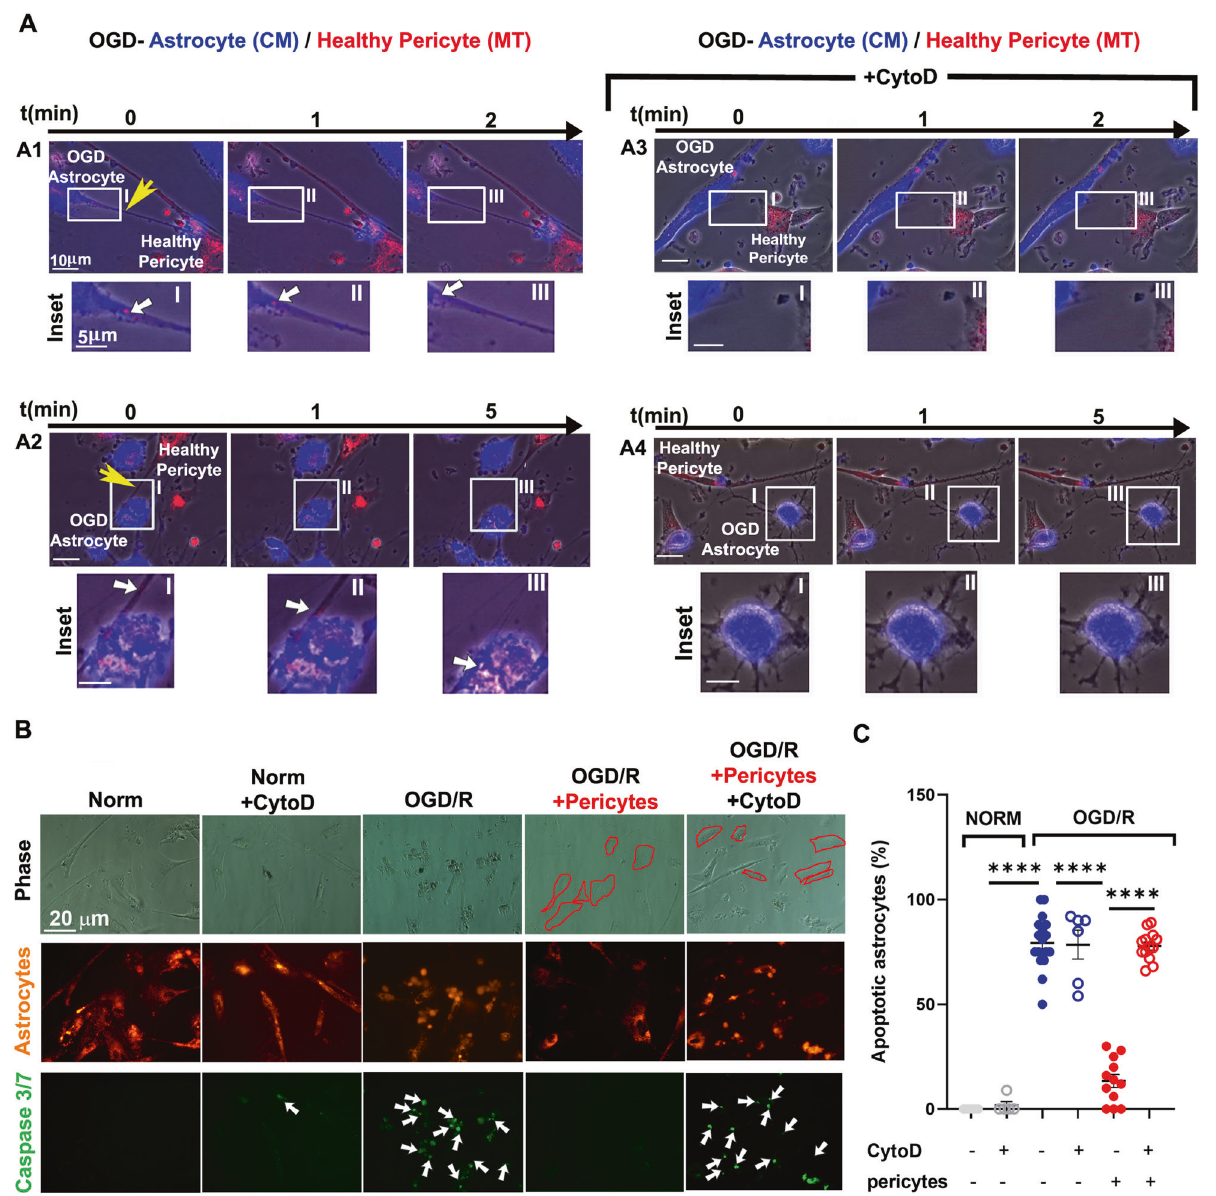
Fig. 5 TNT-mediated mitochondrial transfer from pericytes rescues OGD-induced apoptosis of astrocytes. Astrocytes were stained with CM and exposed to 2% O 2 for 24 h in glucose- and serum-free medium, washed and refreshed in normal complete medium with a constant number of healthy MT-stained pericytes (OGD/R), in the presence or absence of CytoD (200 nM), as described in Fig. 4A. Twenty-four hours later, the co-culture was analyzed for mitochondria traf fi cking and astrocyte apoptosis by time-lapse and confocal fl uorescence microscopy. A Time-lapse fl uorescence microscopy analysis of mitochondria traf fi cking from healthy pericytes to OGD-astrocytes regenerated for 24 h (OGD/R) in the absence or presence of CytoD. TNT and actively transported mitochondria from healthy pericytes to OGD-astrocytes are indicated by yellow and white arrows, respectively (A1 and Suppl. Movie 10; A2 and Suppl. Movie 11 for OGD-astrocytes with overt morphological alterations). CytoD abolished TNT formation and strongly reduced the intercellular mitochondria traf fi cking to OGD-astrocytes (A3; Suppl. Movie 12) also when astrocytes are morphologically altered (A4; Suppl. Movie 13). Representative images from N = 4 independent experiments in which N ≥ 10 areas per experiment were analyzed. B Apoptosis of OGD-astrocyte regenerated for 24 h (OGD/R) with healthy pericytes in the presence or absence of CytoD. Astrocytes (orange) that were positive for CellEvent Caspase 3/7 (green nuclei, white arrows) were counted under the experimental conditions reported in the images. C Analysis of OGD-astrocyte apoptosis. The percentage of Caspase 3/7-positive astrocytes on the total astrocyte population is shown. Pericytes rescued astrocytes from OGD-induced apoptosis only in the presence of an intact F-actin cytoskeleton. N = 3 independent experiments. **** p < 0.0001; Student ’ s t-test (normoxia); two-way ANOVA/ Tukey ’ s tests between healthy pericytes to post-ischemic apoptotic astrocytes could represent a new mechanism to maintain astrocyte survival and BBB functionality. This mechanism could contribute to a better understanding of the restorative role and stem cell-like behavior of pericytes during BBB recovery after ischemic stroke.